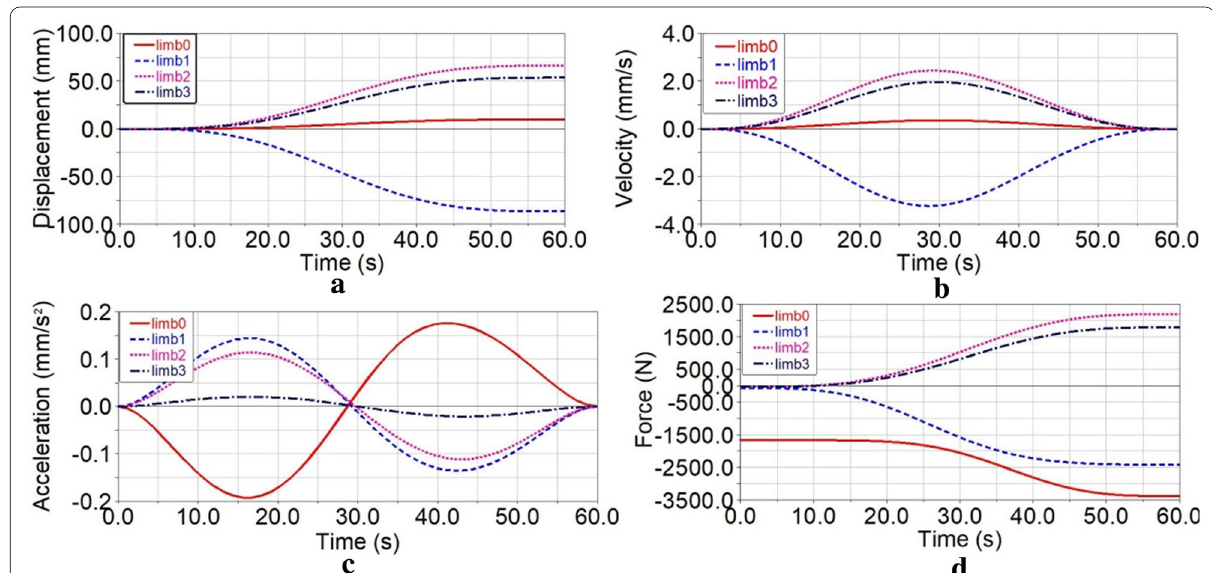
Figure 8 a Displacement, b velocity, c acceleration, and d driving force of each limb of module 1